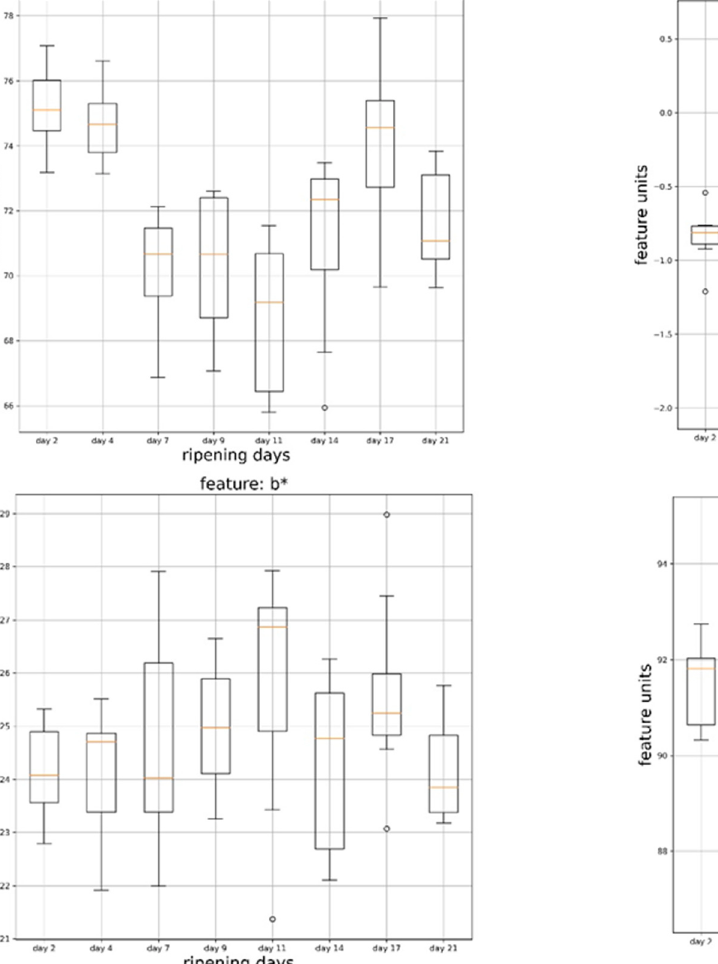
Figure 6. Lightness (L*), redness/greenness (a*), yellowness/blueness (b*), and hue angle (h) of the banana-flesh samples during storage at 18.0 ± 0.5 °C.